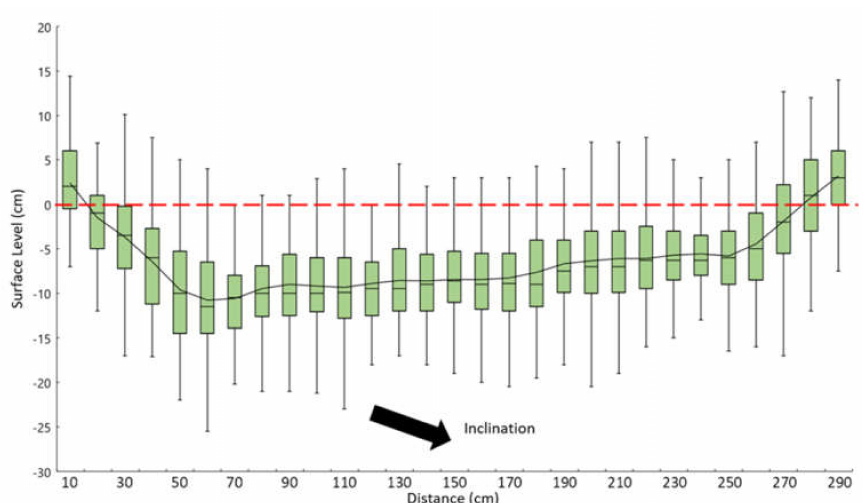
Figure 3. Boxplot of the surface level at the 29 measuring points between the opposite pair-vines along with the 99 pair-vines measurements (2871 measuring points in total). The horizontal line of the boxes represents the median, the rectangular boxes are the 5th and 95th percentiles, and the continuous line that crosses the diagram is the total average. The whiskers represent the maximum and minimum. The dashed line represents the initial soil surface level.